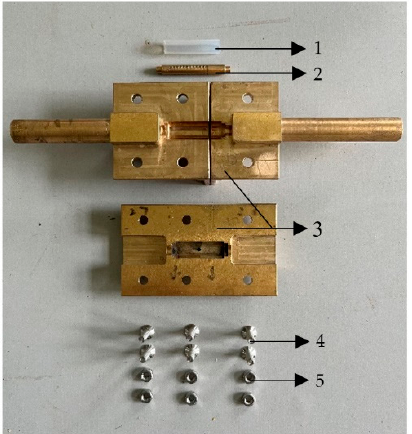
Figure 6. Schematic diagram of the variable flow emitter and testing device made by the computerized numerical control technology. Note: 1. Teflon elastomer; 2. Core body; 3. Special test equipment; 4. Screw; 5. Nut.